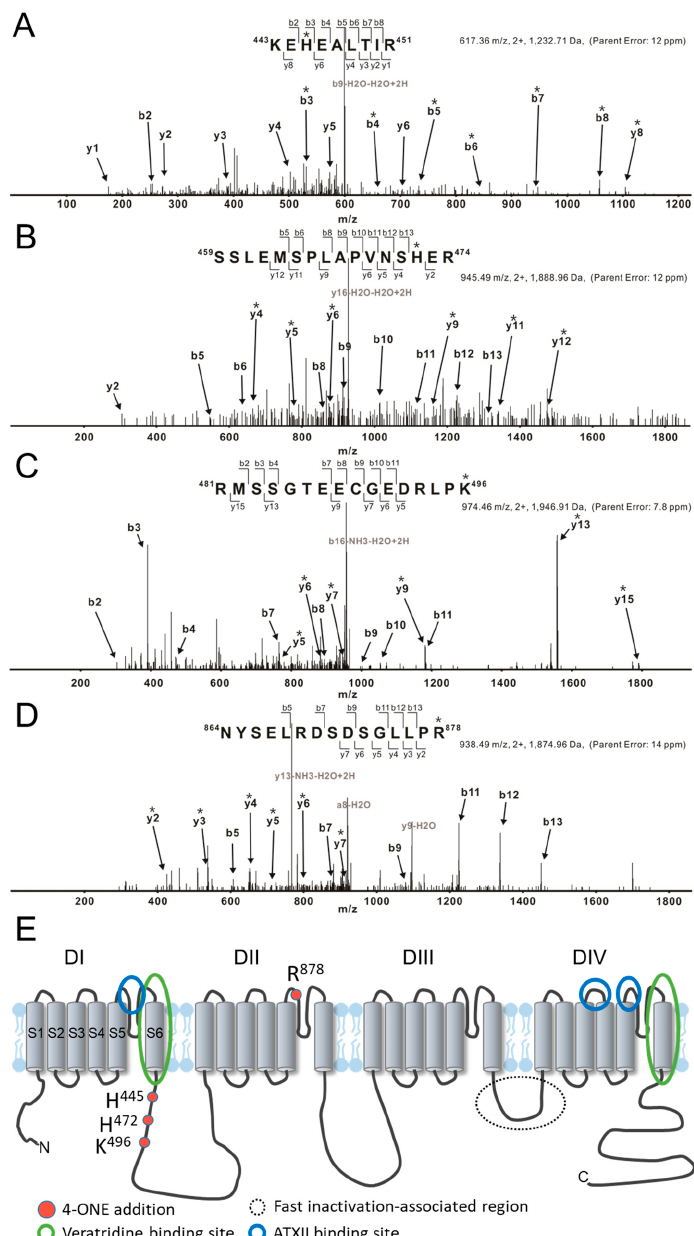
Figure 3. LC/MS/MS CID mass spectra of 4-ONE-modified hNa V 1.5 peptides. ( A – D ) Tryptically digested peptides are fragmented to KEhEALTIR, SSLEMSPLAPVNShER, RmSSGTEECGEDRLPk, and NYSELRDSDSGLLPr, respectively. The sites of the 4-ONE Schiff base addition ( A – C ) or Mi- chael addition ( D ) are localized to His 445 , His 472 , Lys 496 , and Arg 878 by analysis of b and y ion frag- mentation patterns. The product ions containing 4-ONE addition are indicated with asterisks (*).